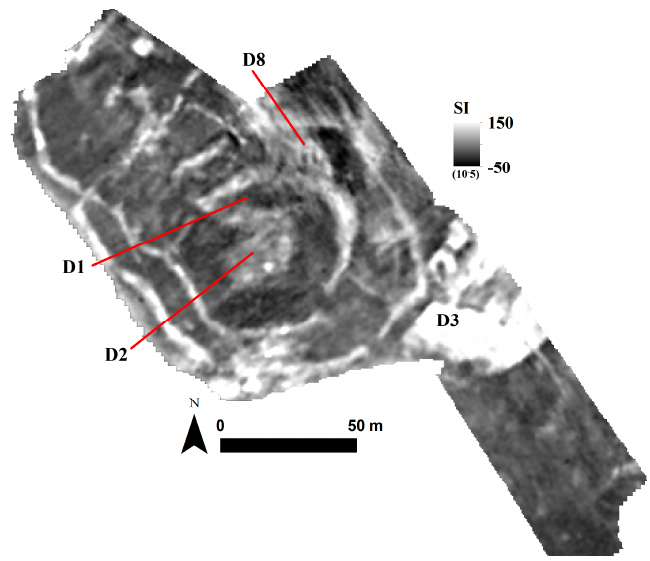
Figure 15. Magnetic susceptibility survey results from Perdika 2.